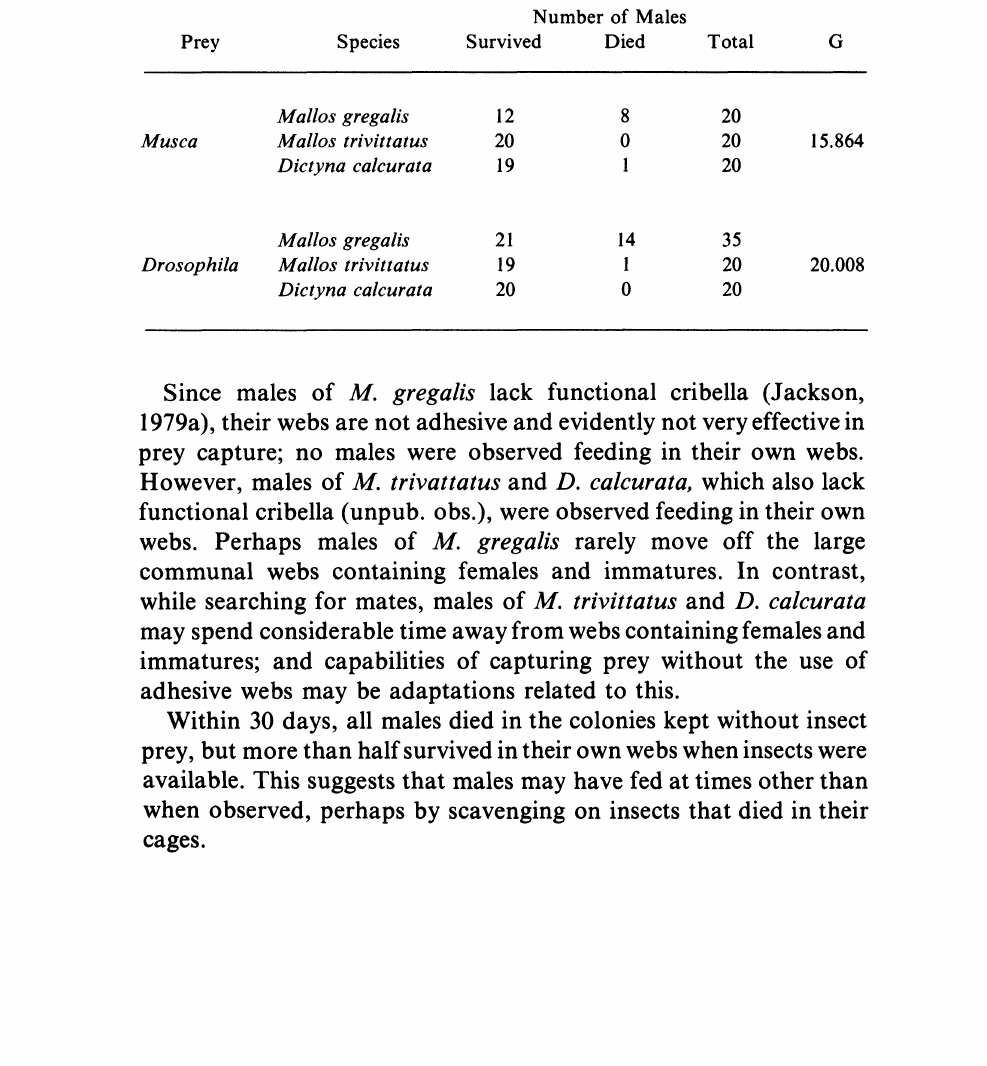
Table 1. Adult males of three different species maintained for 30 days with either Musca domestica or Drosophila melanogaster provided as prey. G-tests of indepen- dence, with Yates Correction, carried out separately for survival rates of those provided with each of the two types of prey: P <